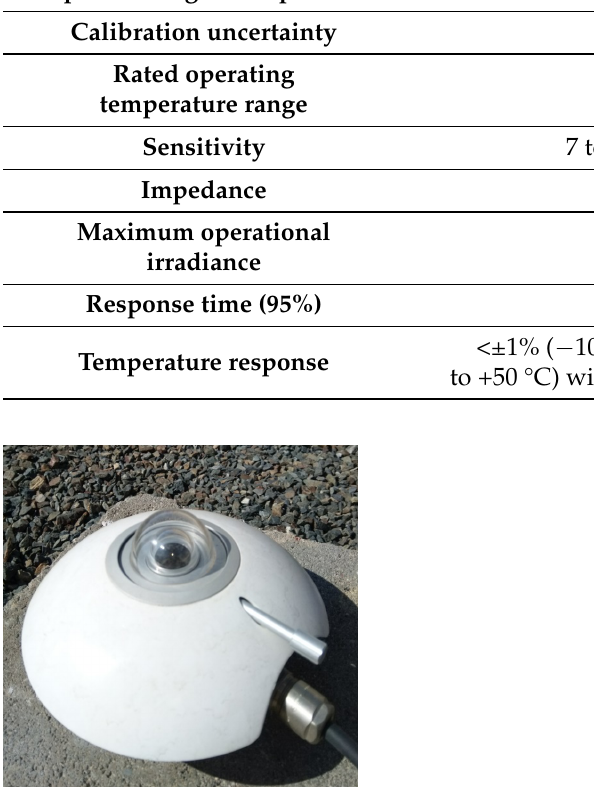
Figure 3. SR20-T2 Py.